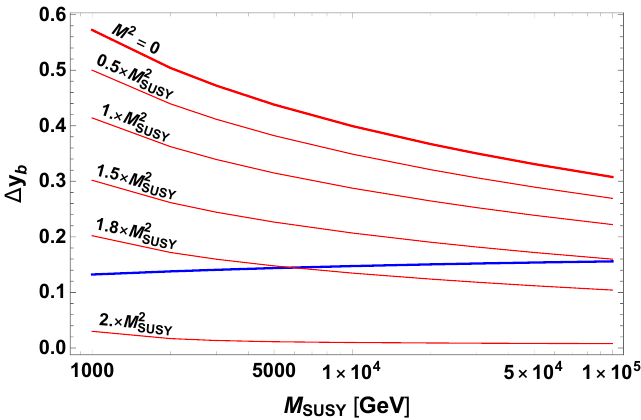
Figure 4 . The M SUSY dependence of the required and maximal SUSY threshold corrections. The blue line shows the required SUSY threshold correction for realizing the SO(10) Yukawa uni(cid:12)cation. The red lines show the maximal SUSY threshold corrections with di(cid:11)erent values of M 2 . The thick red line which is the case with M 2 = 0 corresponds to the maximal SUSY threshold correction in the range of 0 (cid:20) M 2 < 2 M 2 SUSY